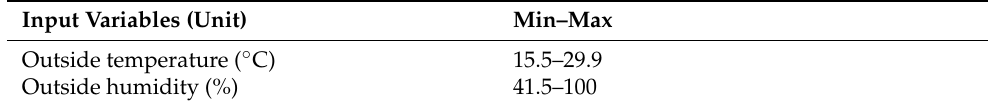
Table 1. Input variable, unit, and range used to develop ET prediction